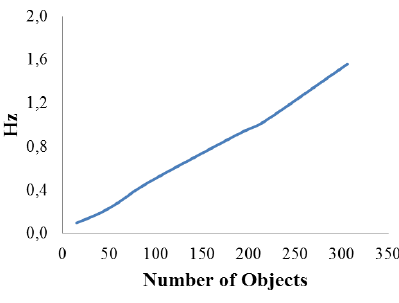
Figure 5. Linear increasing of the inference time for each frame by the increase in the number of objects in the